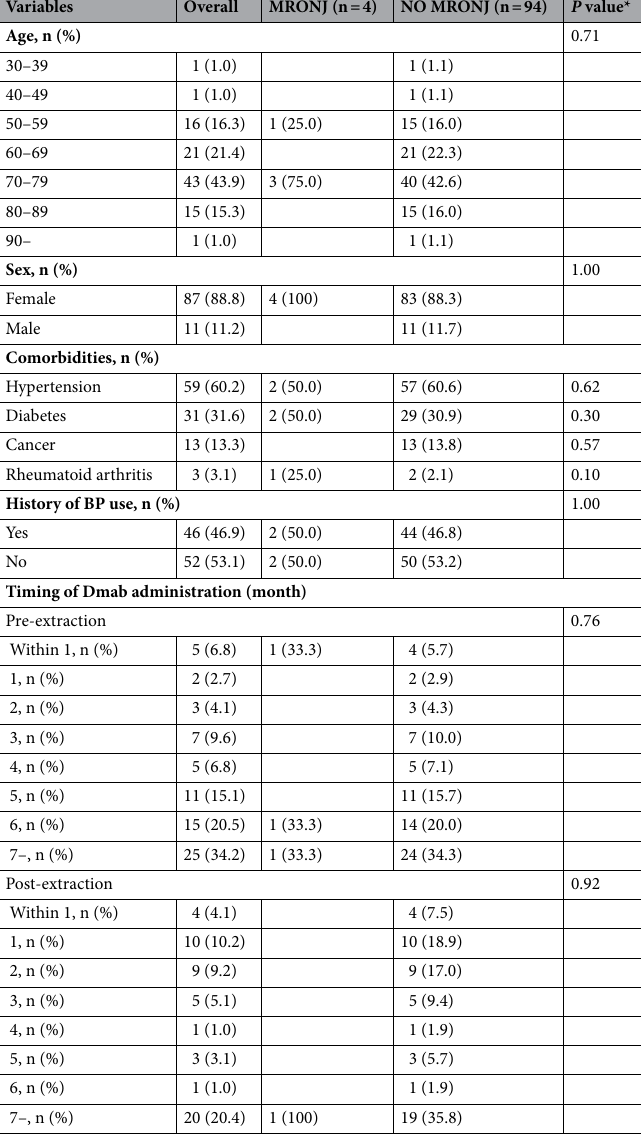
Table 3. The occurrence of MRONJ according to drug administration and timing. Values are n (%), as indicated. The comorbidities has duplicate values. Bp Bisphosphonate, Dmab Denosumab, MRONJ